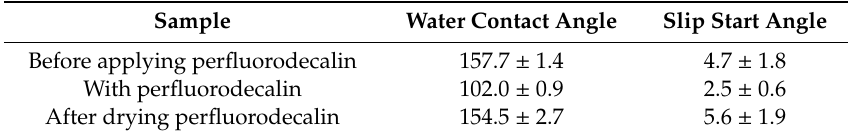
Table 5. Properties of a sample with a hydrophobic coating of Taunit-MD and ethanol (a fraction of